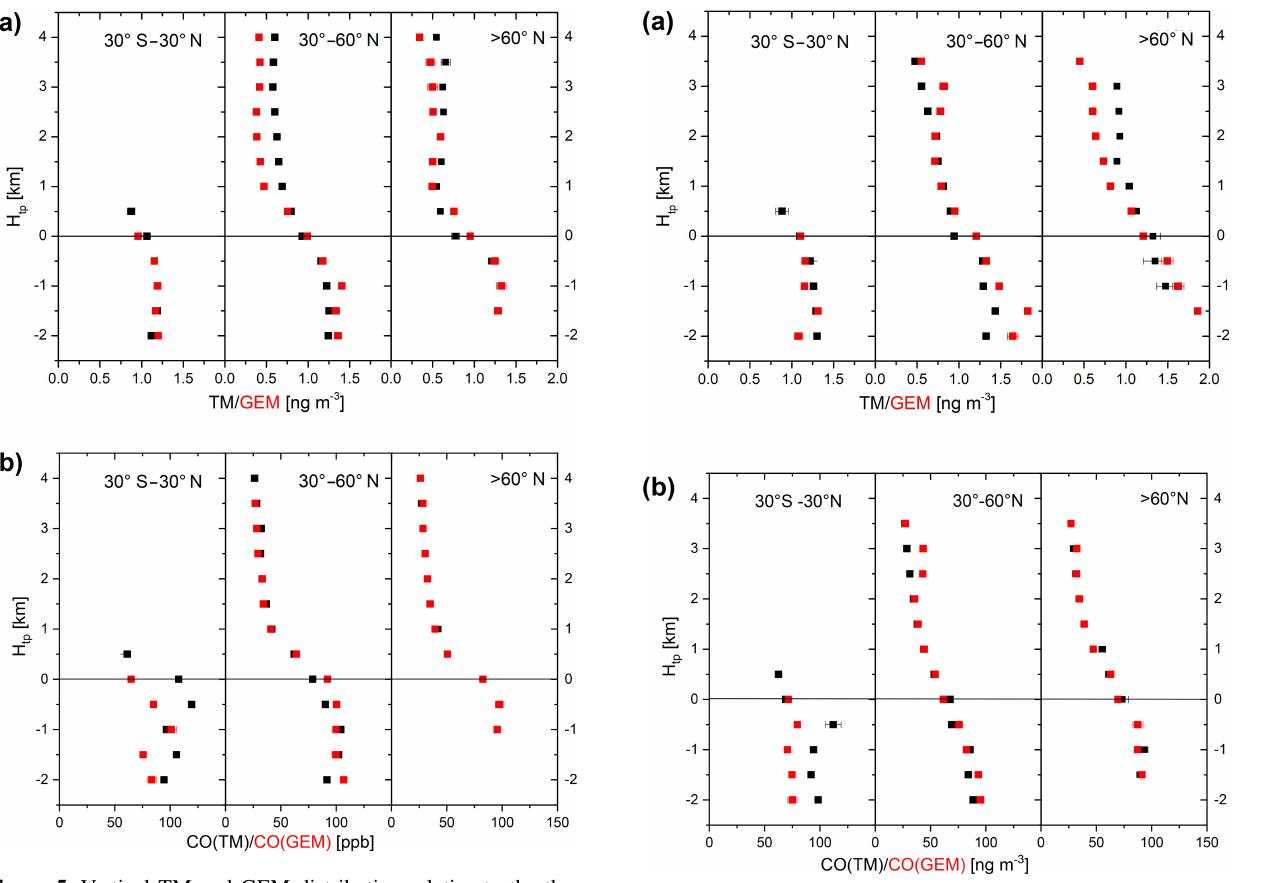
Figure 6. Vertical TM and GEM distribution relative to the ther- mal tropopause in summer (June–November, a ). Panel (b) shows the vertical distribution of CO measured during the TM and GEM measurements. The data points represent averages and their stan- dard errors, extreme TM and GEM values were eliminated using the Nalimov outlier test (Kaiser and Gottschalk,